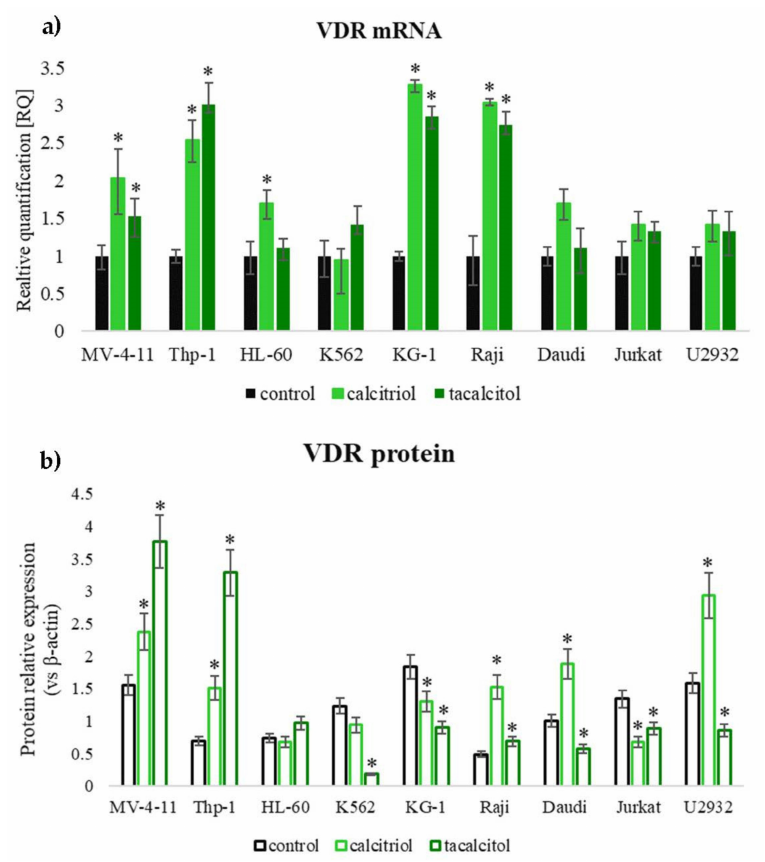
Figure 6. VDR mRNA ( a ) and protein ( b ) level after 120 h of treatment with calcitriol and tacalcitol. *—statistical significance ( p < 0.05) compared to the control. Presented data from three indepen- dent